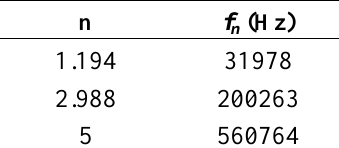
for the standard QTF fork calculated from n